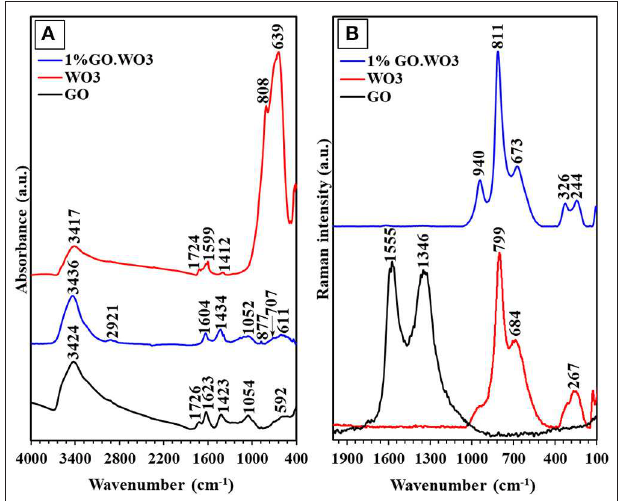
FIGURE 3 | FTIR spectra (A) and Raman spectra (B) of GO, WO 3 ,